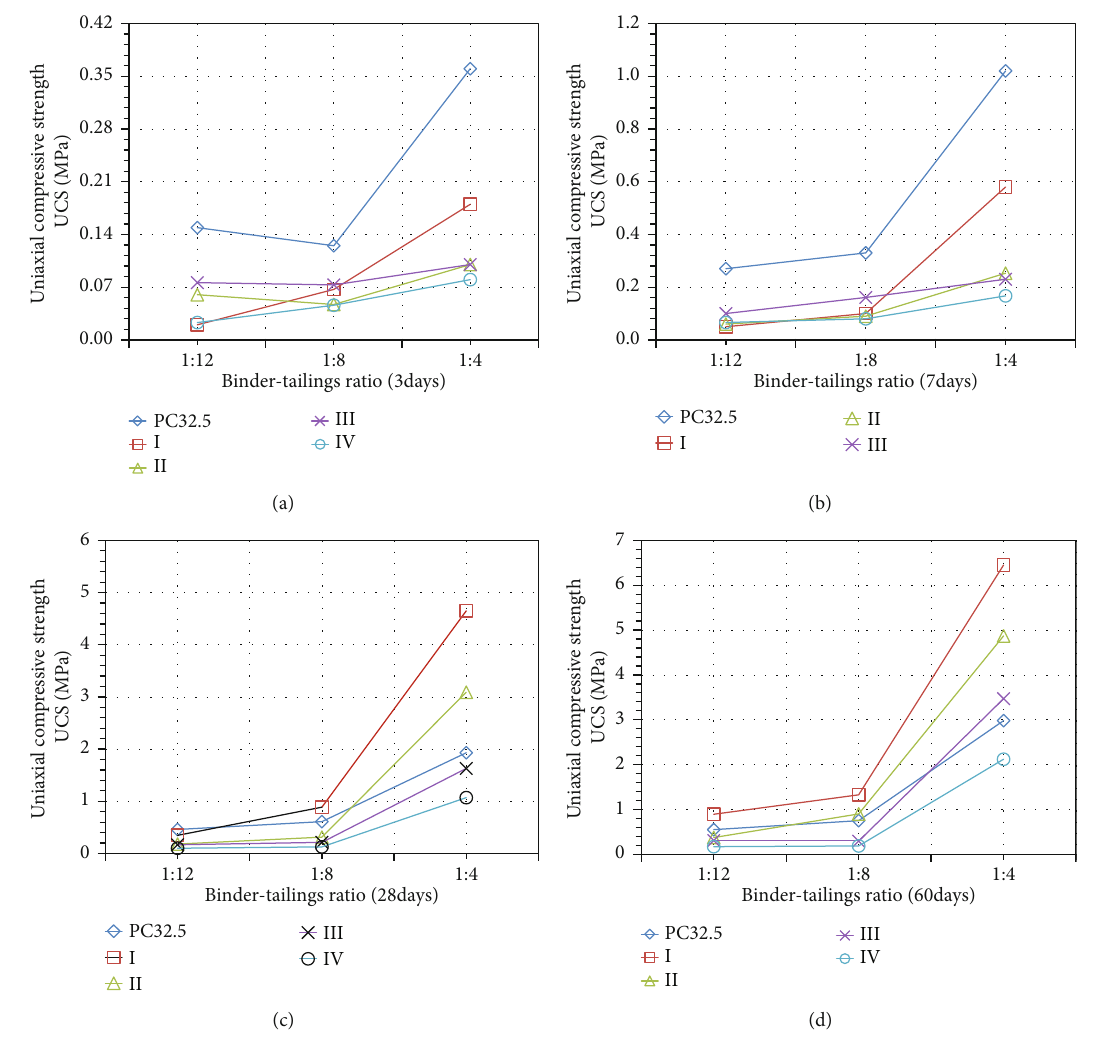
Figure 5: Strength changes with binder-tailing ratio.